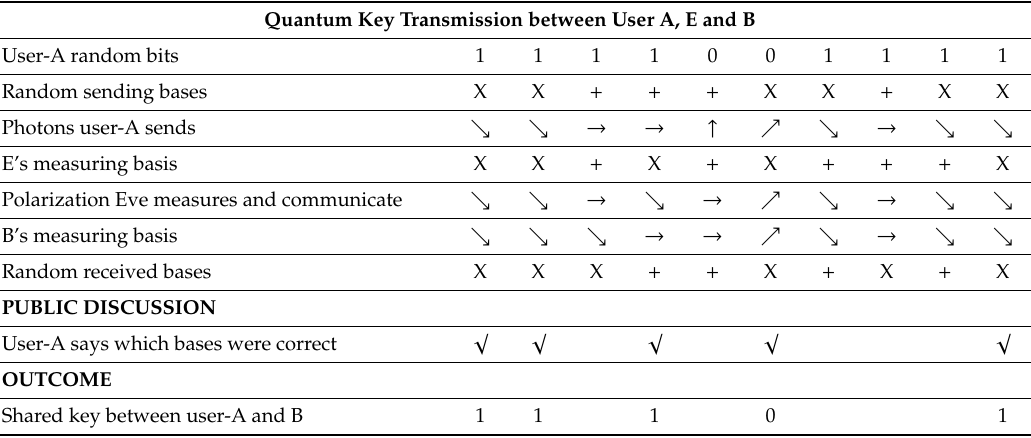
Table 3. Intercept and resend